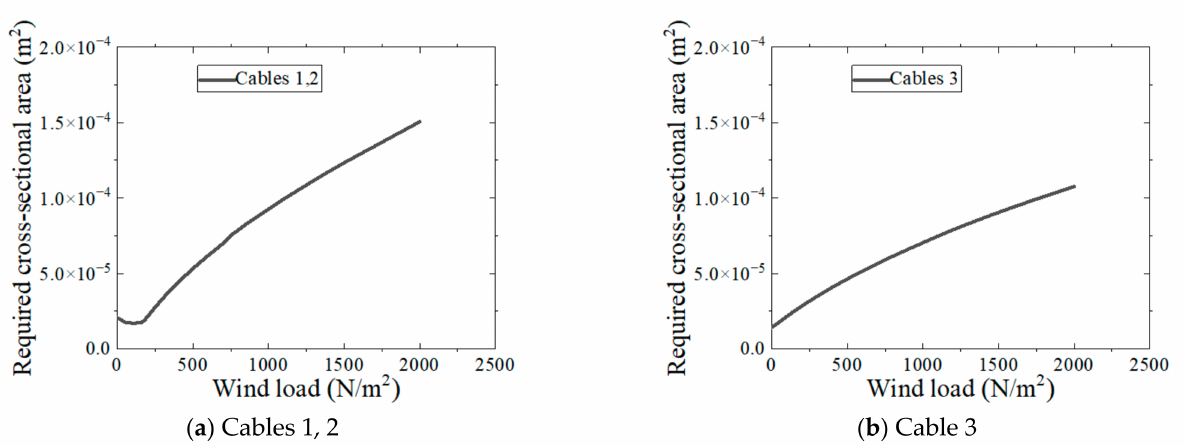
Figure 6. Required cross-sectional